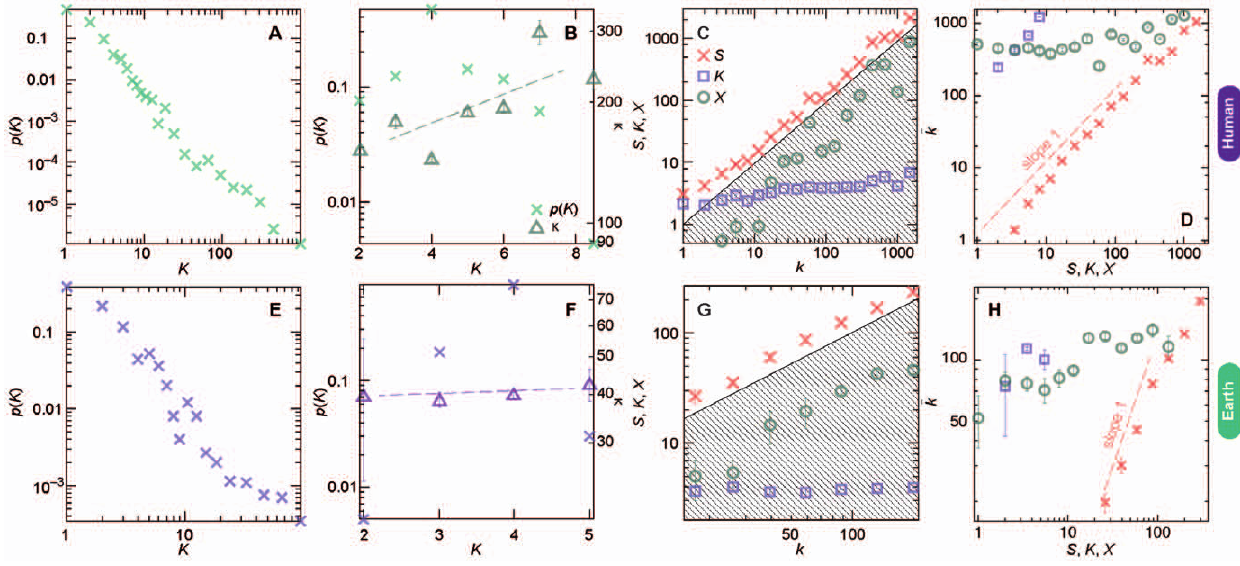
Figure 3. Deeper investigations of the degree distributions. Panel A displays the degree distribution of substances in a bipartite representation of the reaction system, i.e. the probability distribution of the number of reactions a substance participates in. Panel B shows the corresponding plot for reactions and also the average degree of neighbors. The dashed line is a linear-regression line to highlight the trend in k . C and G displays the values of the three bipartite-network terms of k — S (the sum of the degrees of neighbors), K (the degree) and X (the number of four-cycles the vertex participates in). The diagonal line shows the k -value (so if you subtract the values of circles and squares from the values of crosses you would get this line). Panel D and H shows the average degrees (cid:2) kk of nodes with certain values of the three terms that contribute to the degree in the projected reaction networks. (cid:2) kk is averaged over logarithmic bins of S , K , and X values. The dashed line is a reference corresponding to a linear (cid:2) kk -dependence. Panels A–D are for the human metabolic reaction networks, E–H show the corresponding plots for the Earth atmospheric reaction networks.